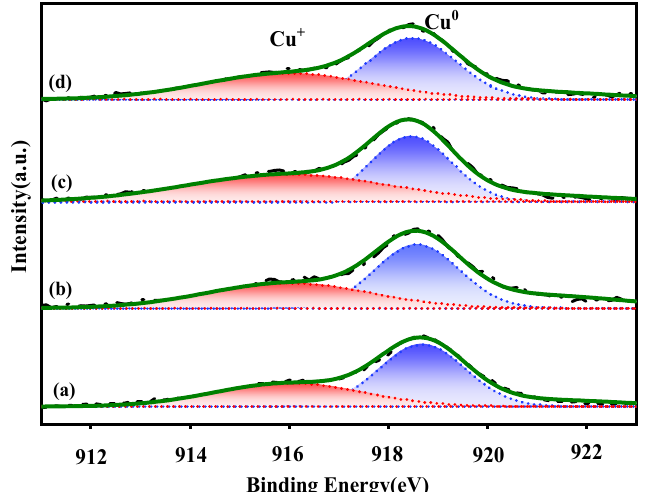
Figure 6. Cu LMM XAES spectra of the reduced catalysts. ( a ) CZA, ( b ) CZAGa-1, ( c ) CZAGa-2, ( d ) CZAGa-3.